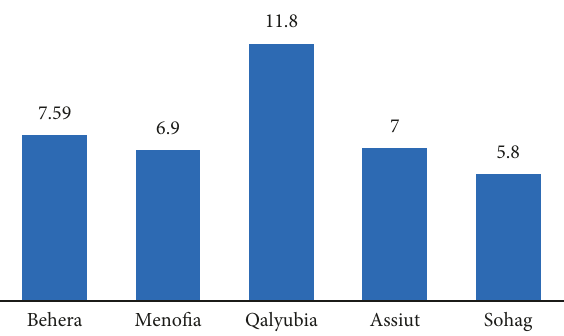
Figure 3: Prevalence of Cryptosporidium bovis infection of calves among different governorates of Egypt.